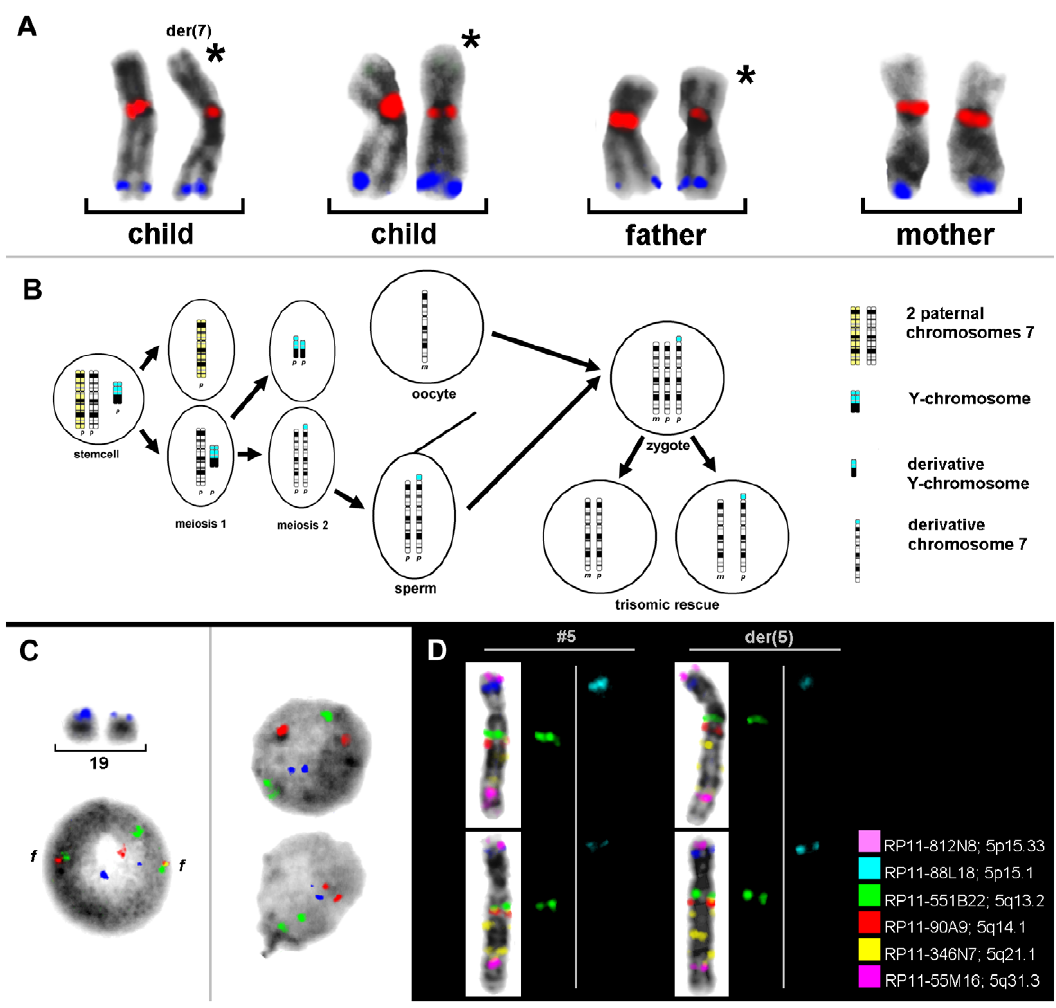
Figure 1. Single-cell estimation of CNV by using pod-FISH. ( A ) The parental origin of der(7) in an individual with Turner syndrome and the mosaic karyotype 45,X,der(7)t(Y;7)(p11.1 , 11.2;p22.3)[122]/45,X[48] was detected with RP11-533E18 (red, 7q11.21–7q11.1) and RP11-45N9 (blue, 7q34). ( B ) The homologous chromosomes 7 of the father and der(7) of the child are marked with asterisks. The suggested development of this rare mosaic karyotype is shown schematically. ( C ) Different signal intensities for the CNV at 19p13.2 (RP11-367L15, blue) are apparent on the two homologous chromosomes 19 in metaphase, and in the interphase nuclei of all cells of an AML patient with t(8;21)(q22;q22.3) before bone-marrow transplantation (left). In the bone-marrow donor cells, 55% of the cells showed no signal intensity difference in the CNV region detected with RP11- 367L15 (blue) at 19p13.2 (right, upper nucleus). However, the remaining 45% of the recipient cells showed signal intensity differences identical to those of the recipient (right, lower nucleus). As well as RP11-367L15 (blue), probes for AML1 (21q22.3, green) and ETO (8q22, red) were also applied, showing two fusion signals (f) in the patient cells. ( D ) pod-FISH using six BACs specific for different CNV regions on chromosome 5 in a patient with normal chromosome 5 and der(5) revealed different signal intensity patterns for BAC RP11-551B22 (green) and RP11-88L18